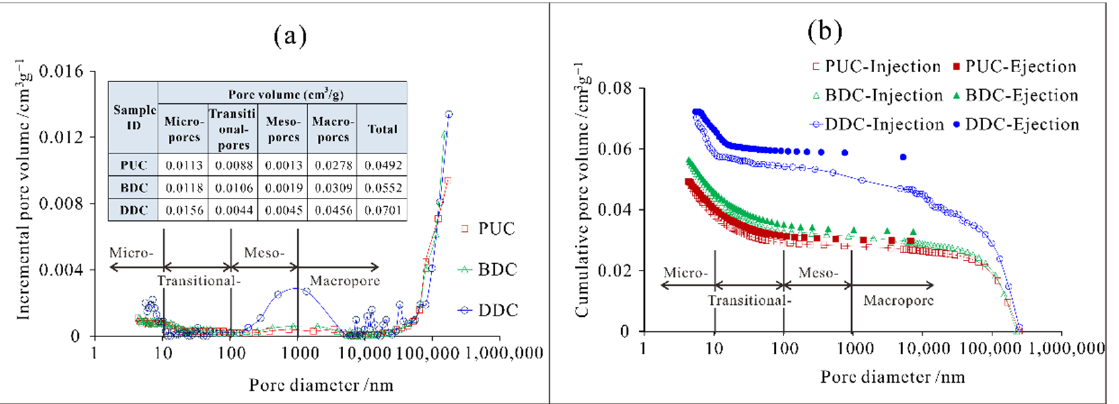
Figure 4. Pore distribution and connectivity based on mercury injection experiments: ( a ) is the pore distribution; ( b ) is the pore connectivity.